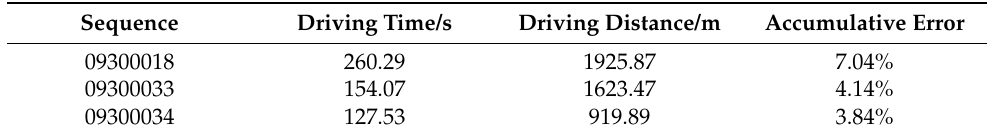
Figure 7. Cumulative error curve of three sequences: ( a ) X direction position error; ( b ) Y direction position error. Table 5. Information of each sequence.